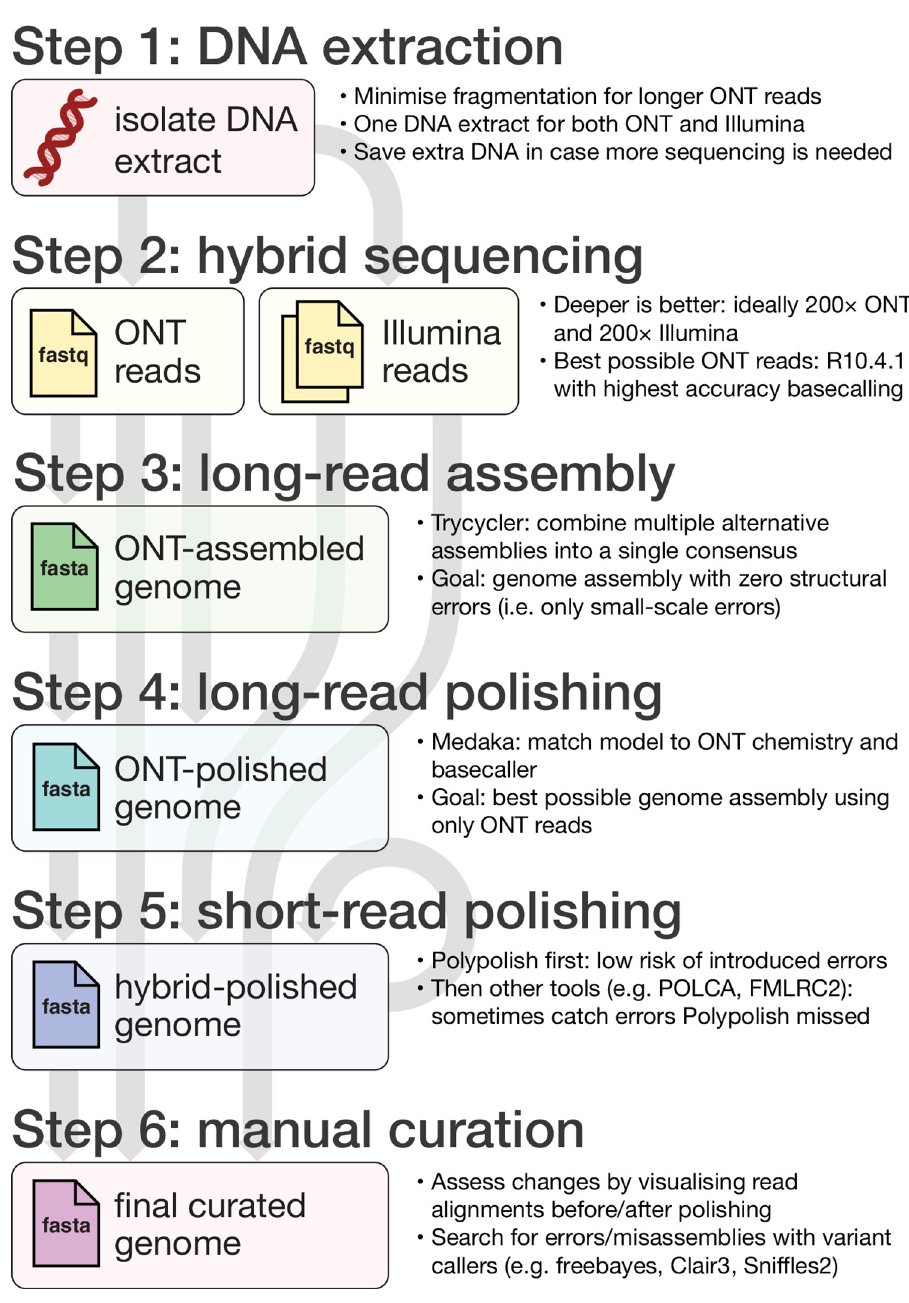
Fig 1. Illustrated overview of our recommended approach to perfect bacterial whole-genome